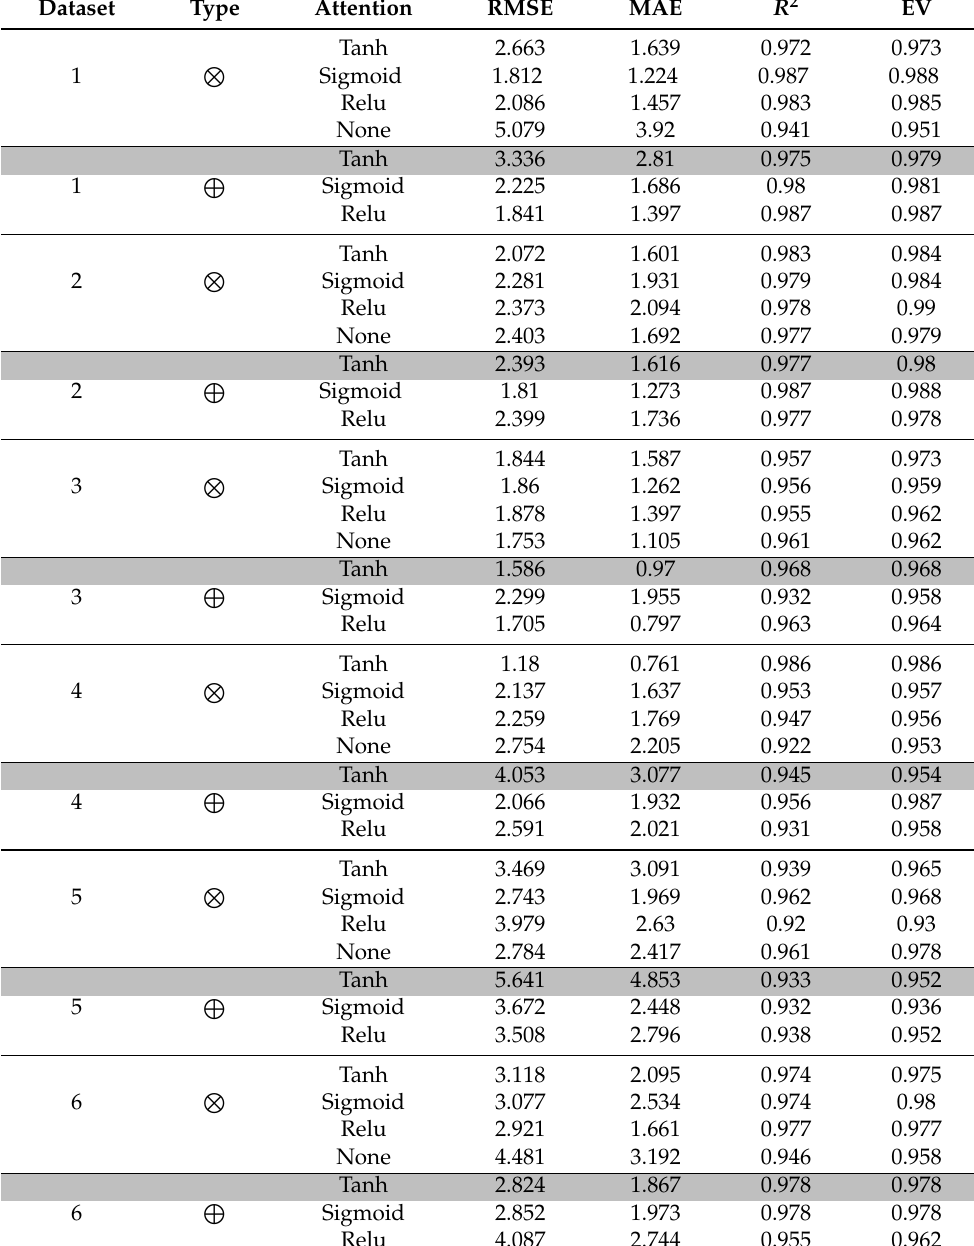
Table 6. Evaluation of the forecasting performance of the GAHD-VAE under different configura- tions of the attention mechanism. (cid:76) is the additive attention mode, while (cid:78) is the multiplicative attention